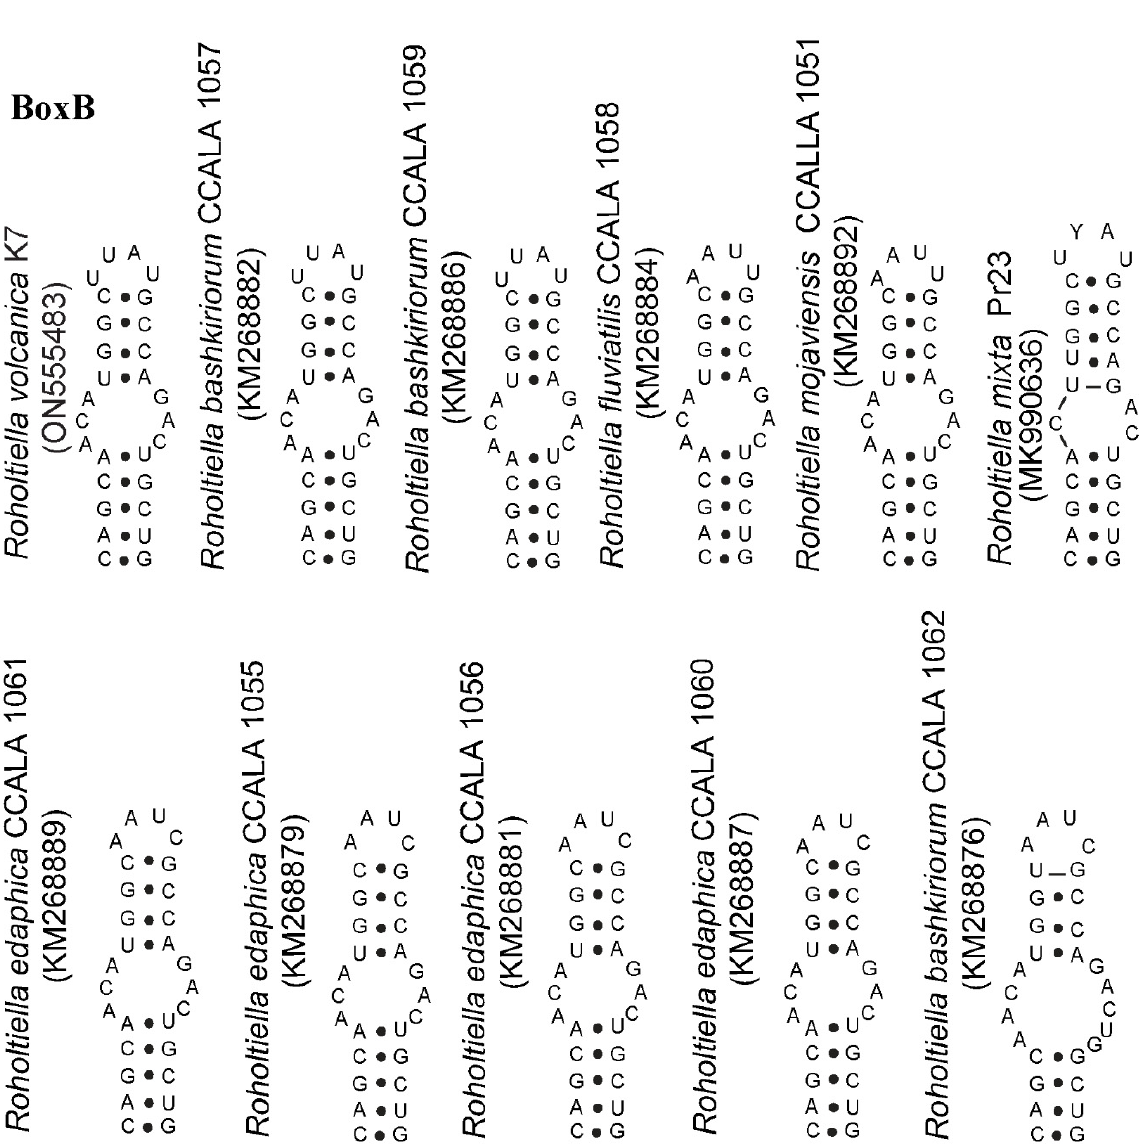
Figure 5. Comparative secondary structure analysis of the BoxB region of Roholtiella volcanica K7 with the other members of the genus Roholtiella .